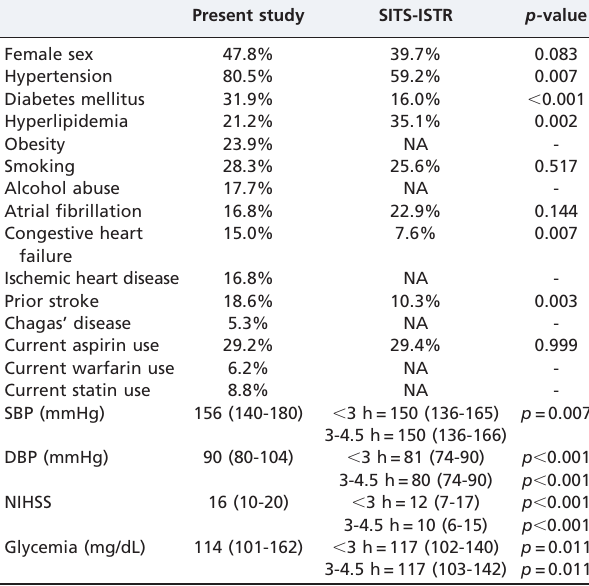
Table 1 - A comparative analysis of patient demographic, medical history, and clinical and laboratory data.